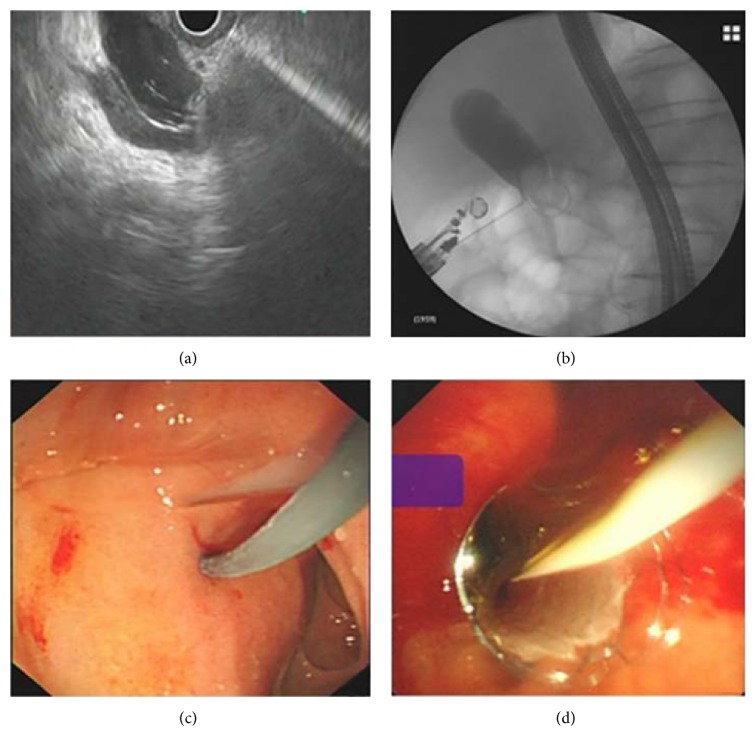
Endoscopic ultrasound-guided choledochoduodenostomy. Under real-time EUS guidance, the dilated extrahepatic bile duct was punctured and a cholangiogram was obtained (a and b). After biliary-enteric fistula dilation (c), a fully covered self-expandable metal stent was deployed (d).